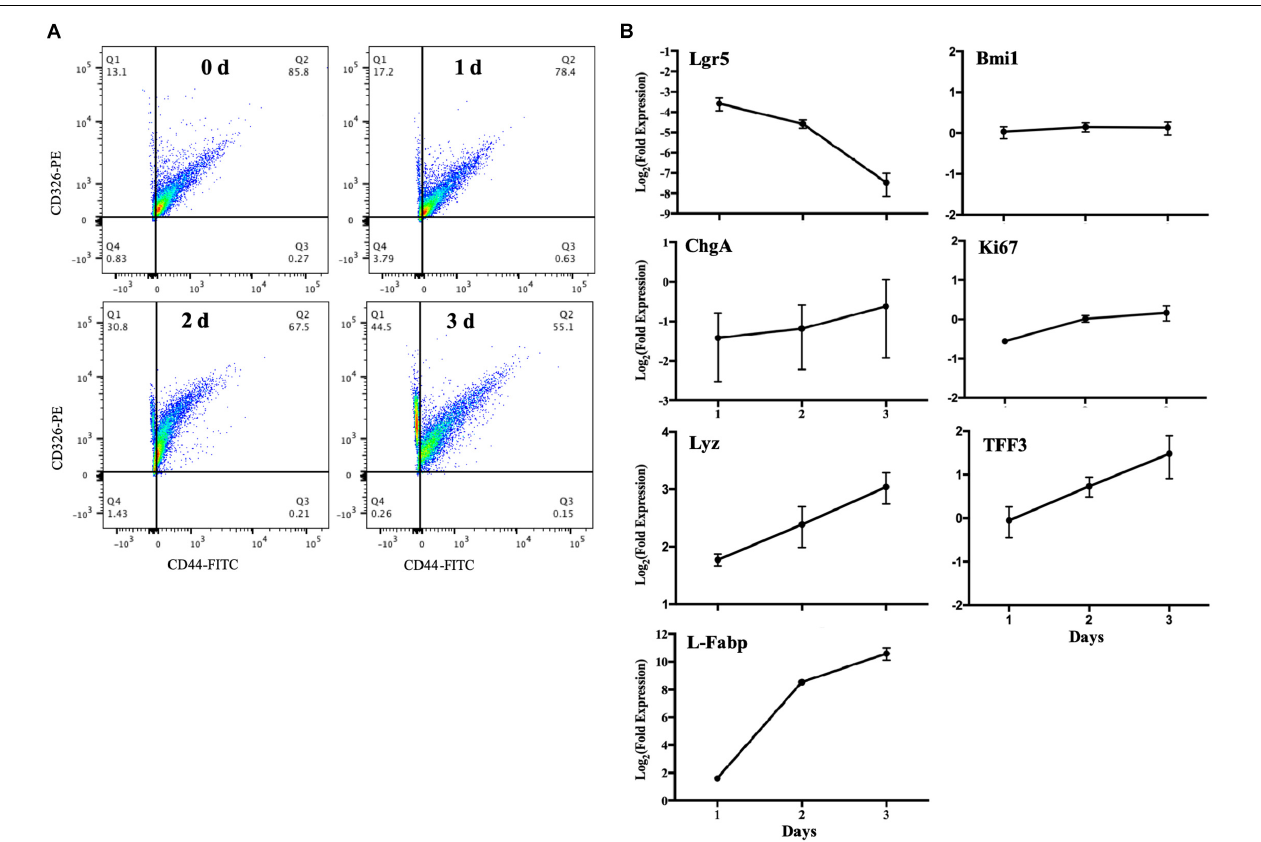
FIGURE 4 | Changes in cellular sub-populations in differentiating MPIEs. (A) CD326 (Epcam) versus CD44 expression in cells harvested at different time points. (B) Transcriptional changes of the major cell marker genes in 3 days of differentiation detected by RT-qPCR. The transcription levels were normalized to that of GAPDH and the relative fold changes were calculated using the 2 − (cid:49)(cid:49) CT . Each bar indicated means ± standard deviations for three independent trials. The abbreviations on the map are leucine-rich-repeat-containing G-protein-coupled receptor 5 ( Lgr5 ), B cell-specific moloney murine leukemia virus integration site 1 ( Bmi1 ), Ki-67 ( Ki67 ), chromogranin A ( ChgA ), trefoil factor 3 ( TFF3 ), lysozyme ( Lyz ) and fatty acid-binding protein 1 ( L-Fabp